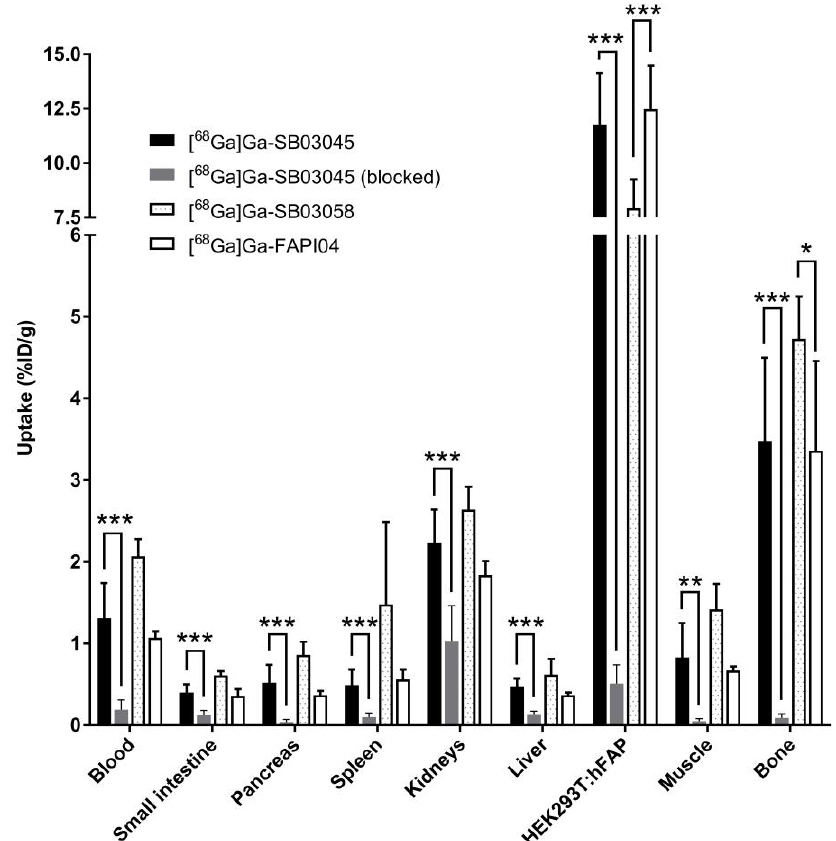
Figure 4. Ex vivo biodistribution of [ 68 Ga]Ga-SB03045, [ 68 Ga]Ga-SB03058, and [ 68 Ga]Ga-FAPI-04 in HEK293T:hFAP tumor-bearing male NRG mice at 1 h pi. The mice in the blocked group were co-injected with nat Ga-FAPI-4 (0.5 mg/mouse). * p < 0.05, ** p < 0.01, *** p < 0.001.